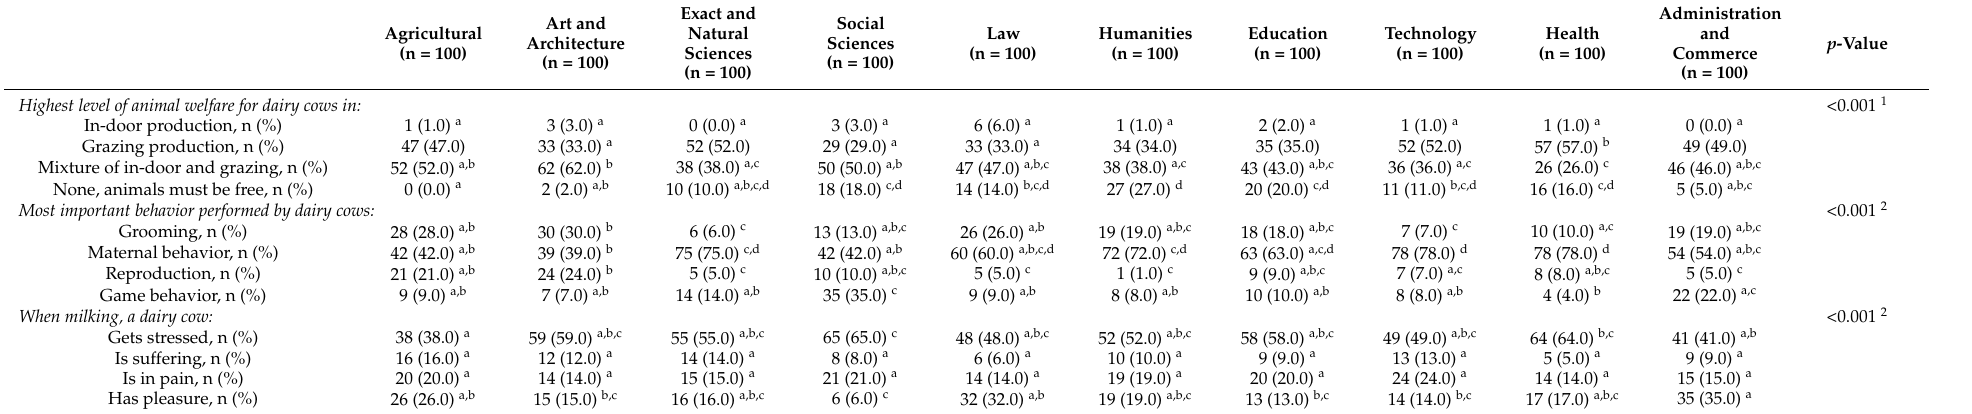
Table 7. Chilean university students’ perceptions toward dairy cows’